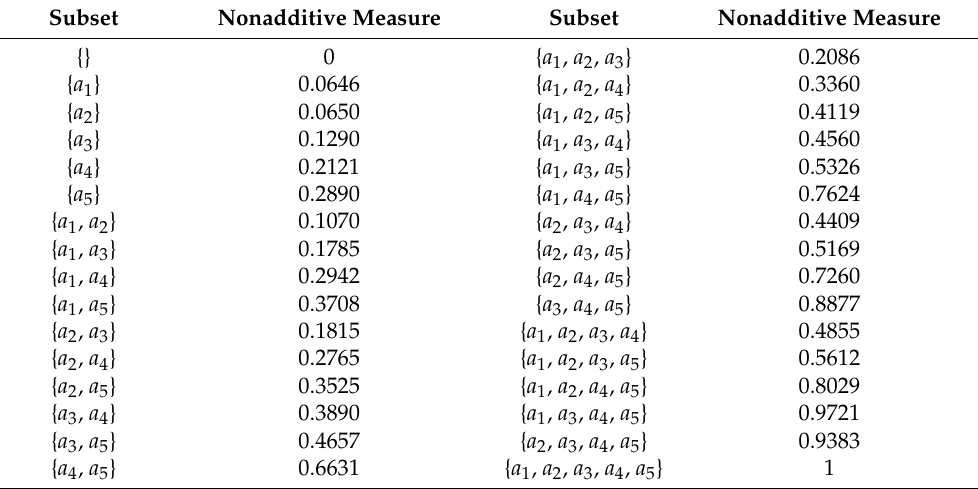
Table 10. Nonadditive measures of set